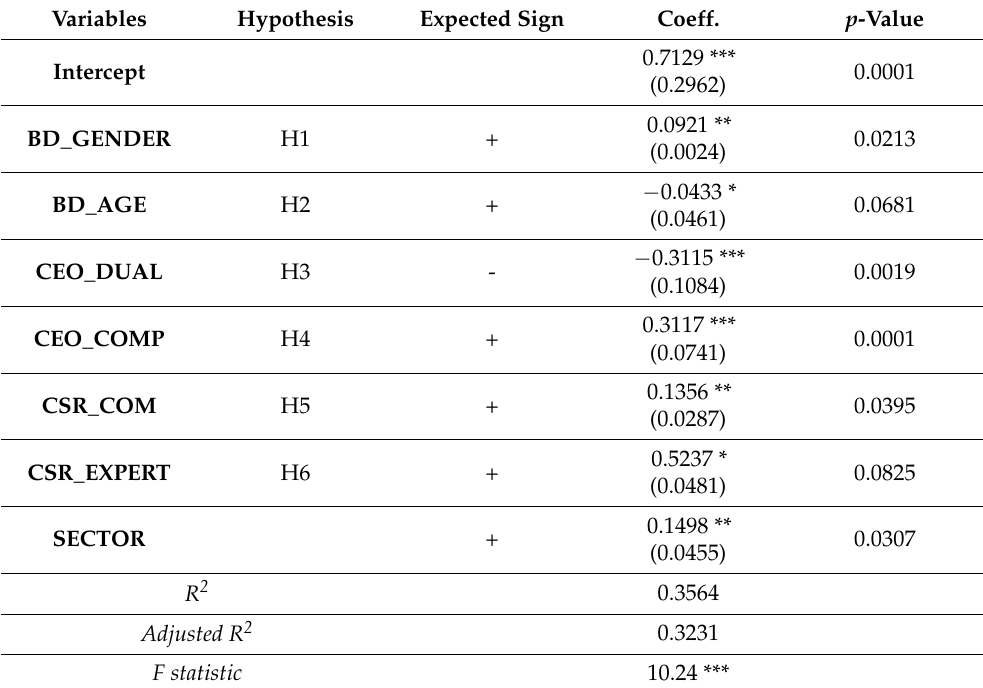
Table 7. Results of random effects regression analyses (GLS with robust standard